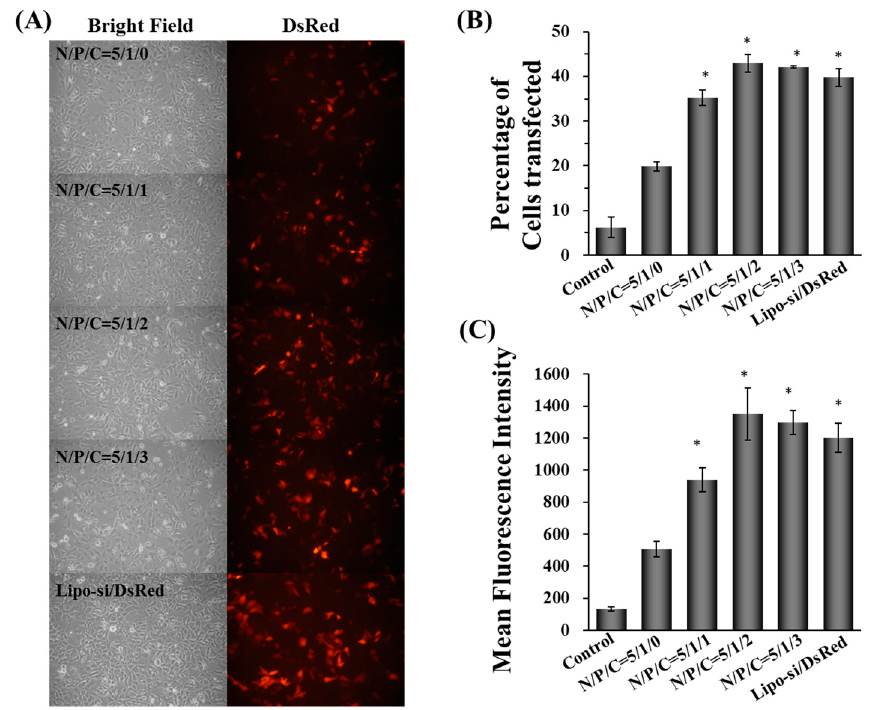
Figure 6. The fluorescent image of DsRed protein expressing Hep 3B cells after 48 h transfection with γ -DDNPs containing various ratio of γ -PGA ( A ). The transfection efficiency of DsRed gene ( B ) and mean fluorescent intensity ( C ) of Hep 3B cells transfected with γ -DDNPs containing various N/P/C ratios for 48 h were examined by flow cytometry. The control group denotes the group of cells without any treatment. * p < 0.05, significant difference between the test groups and the group with N/P ratio of 5/1/0 as analyzed by Student’s t test.